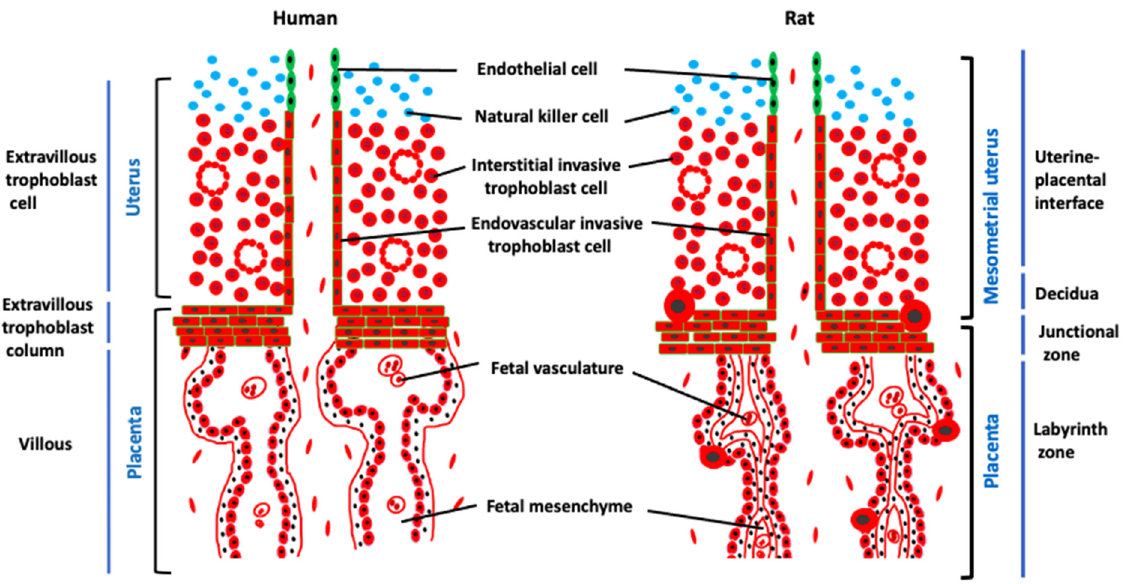
Figure 2. Schematic representations of hemochorial placentation sites of the human and rat highlighting similarities in structural organization. The extravillous trophoblast column and junctional zone are homologous structures of the human and rat, respectively. These structures are the sources of trophoblast cells that invade deep into the uterus. The villous and labyrinth compartments are homologous structures of the human and rat, respectively, and represent the site of maternal-fetal exchange. Histological organization of the villous and labyrinth compartments are defined as hemomonochorial and hemotrichorial, respectively.